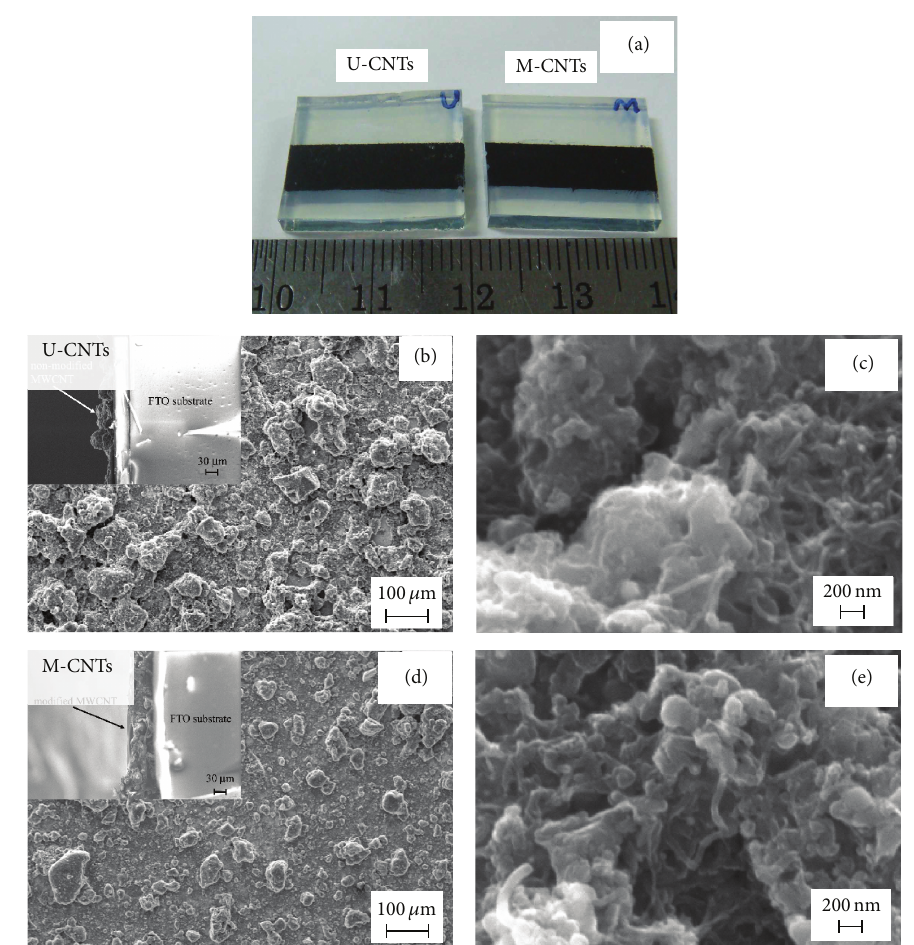
Figure 4: (a) The optical image of U-CNTs and M-CNTs films coated on the conductive glass. (b) Low and (c) high magnification SEM images of U-CNTs film coated on the conductive glass. (d) Low and (e) high magnification SEM images of M-CNTs film coated on the conductive glass.